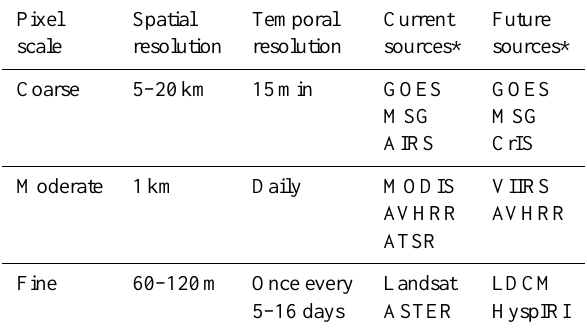
Table 1. Examples of current and future satellite-based TIR imag- ing system, along with characteristic spatial and temporal reso- lutions (table adapted from Hook, http://landportal.gsfc.nasa.gov/ Documents/ESDR/Temp-Emissivity Hook